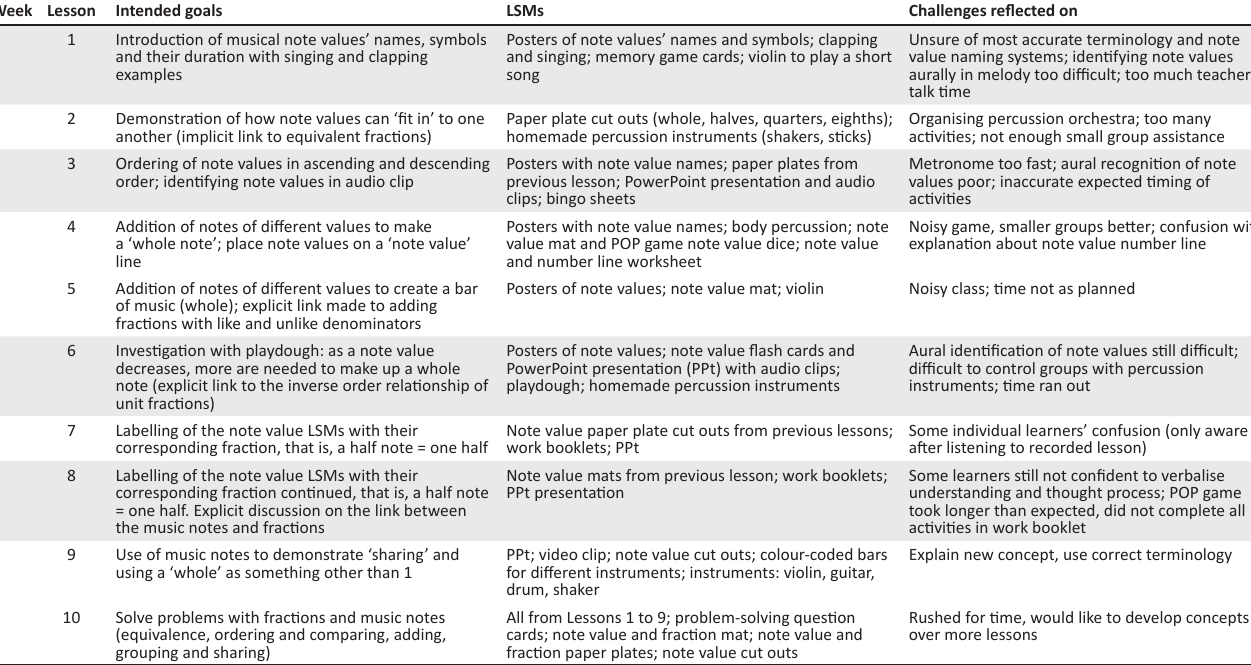
TABLE 1: Outline of intended goals, selection of learning support materials and challenges encountered across the 10-lesson unit. Week Lesson Intended goals LSMs Challenges reflected